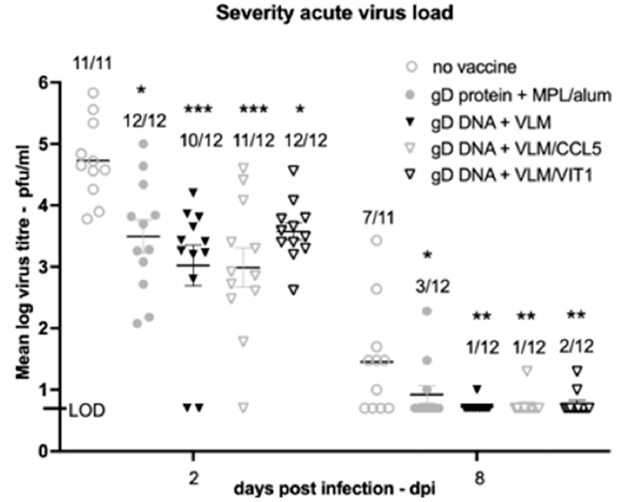
Figure 4. DNA immunisation with VLM vaccines protect against virus replication. The log 10 geometric mean titre (GMT) was assayed for vaginal virus shed for each day post challenge inoculation, with the number of animals having detectable virus shown above each of the bars. LOD shows the limit of detection. The mean and standard deviation are indicated, on day 2 and day 8 pairwise comparisons to no vaccine are analysed, with P < 0.5 (*), <0.01 (**) and <0.001 (***).